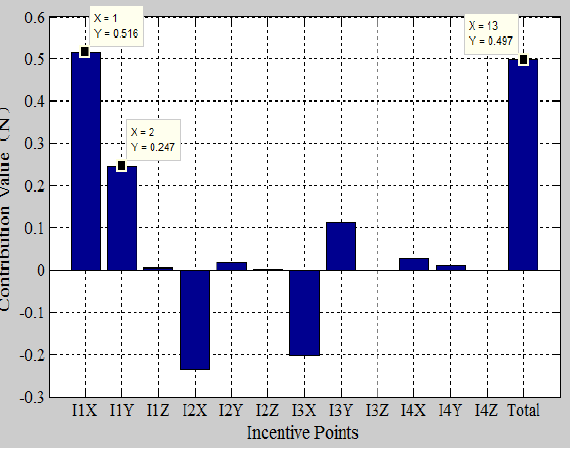
Figure 6. Analysis diagram of Z-direction path contribution of output point O1.